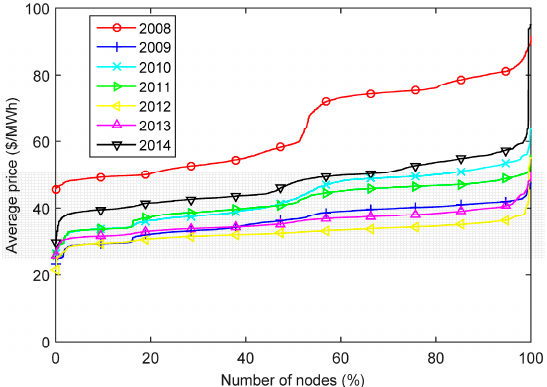
Figure 4. Average electricity prices of RTM in PJM, encompassing 7395 nodes. The abscissa is the percentage of nodes with average price less than the value given by the ordinate. The values are independently sorted by year.